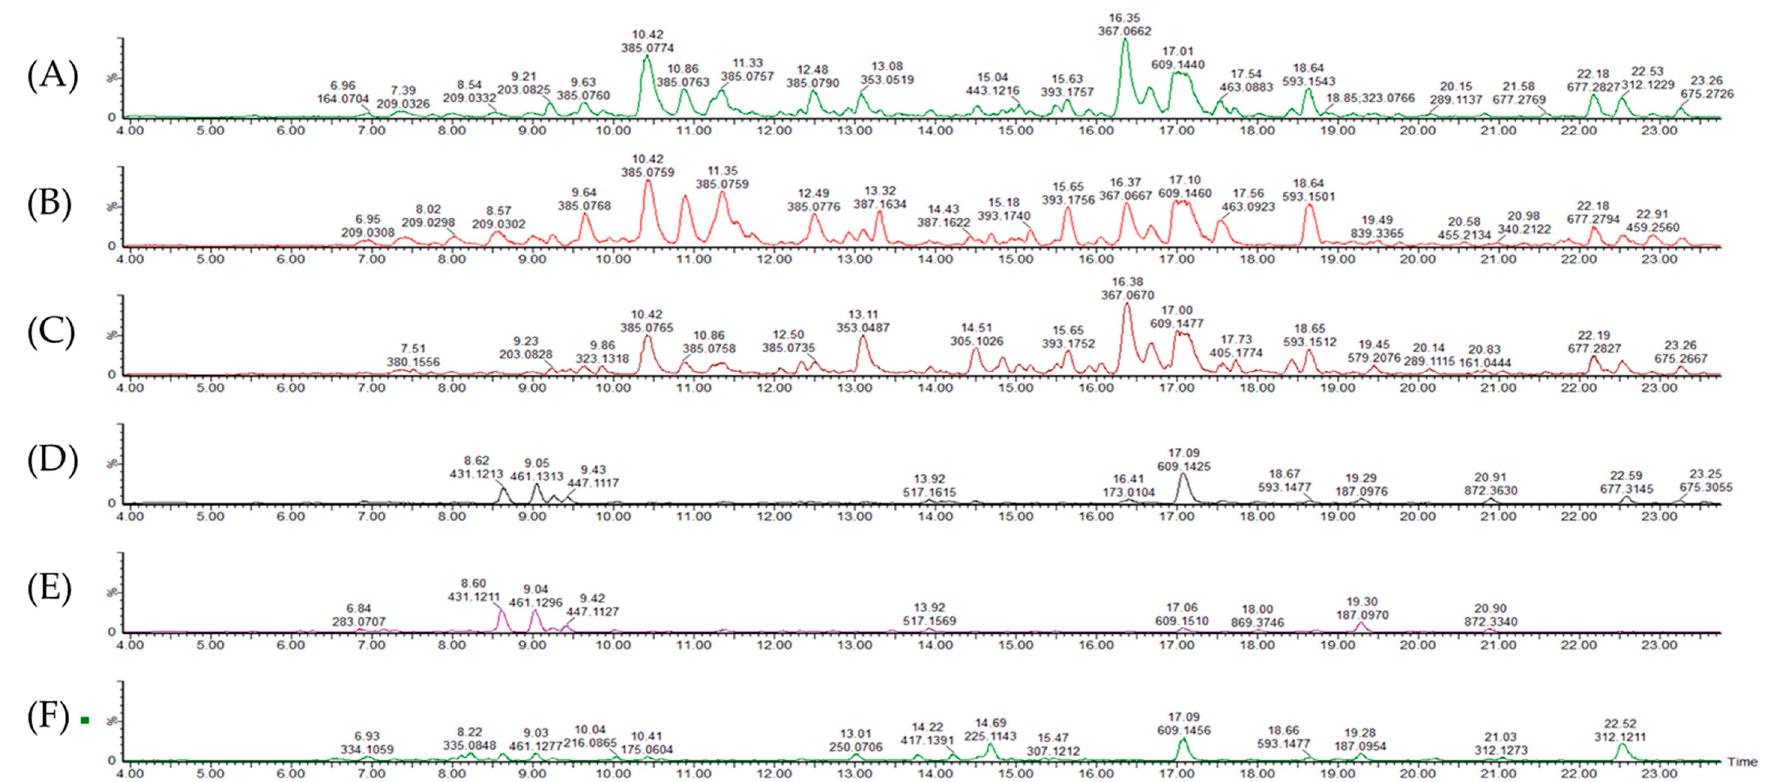
Figure 1. Chromatograms of ( A ) tender leaves, ( B ) mature leaves, ( C ) late maturity leaves, ( D ) mature grains, ( E ) tender grains, and ( F ) flowers.